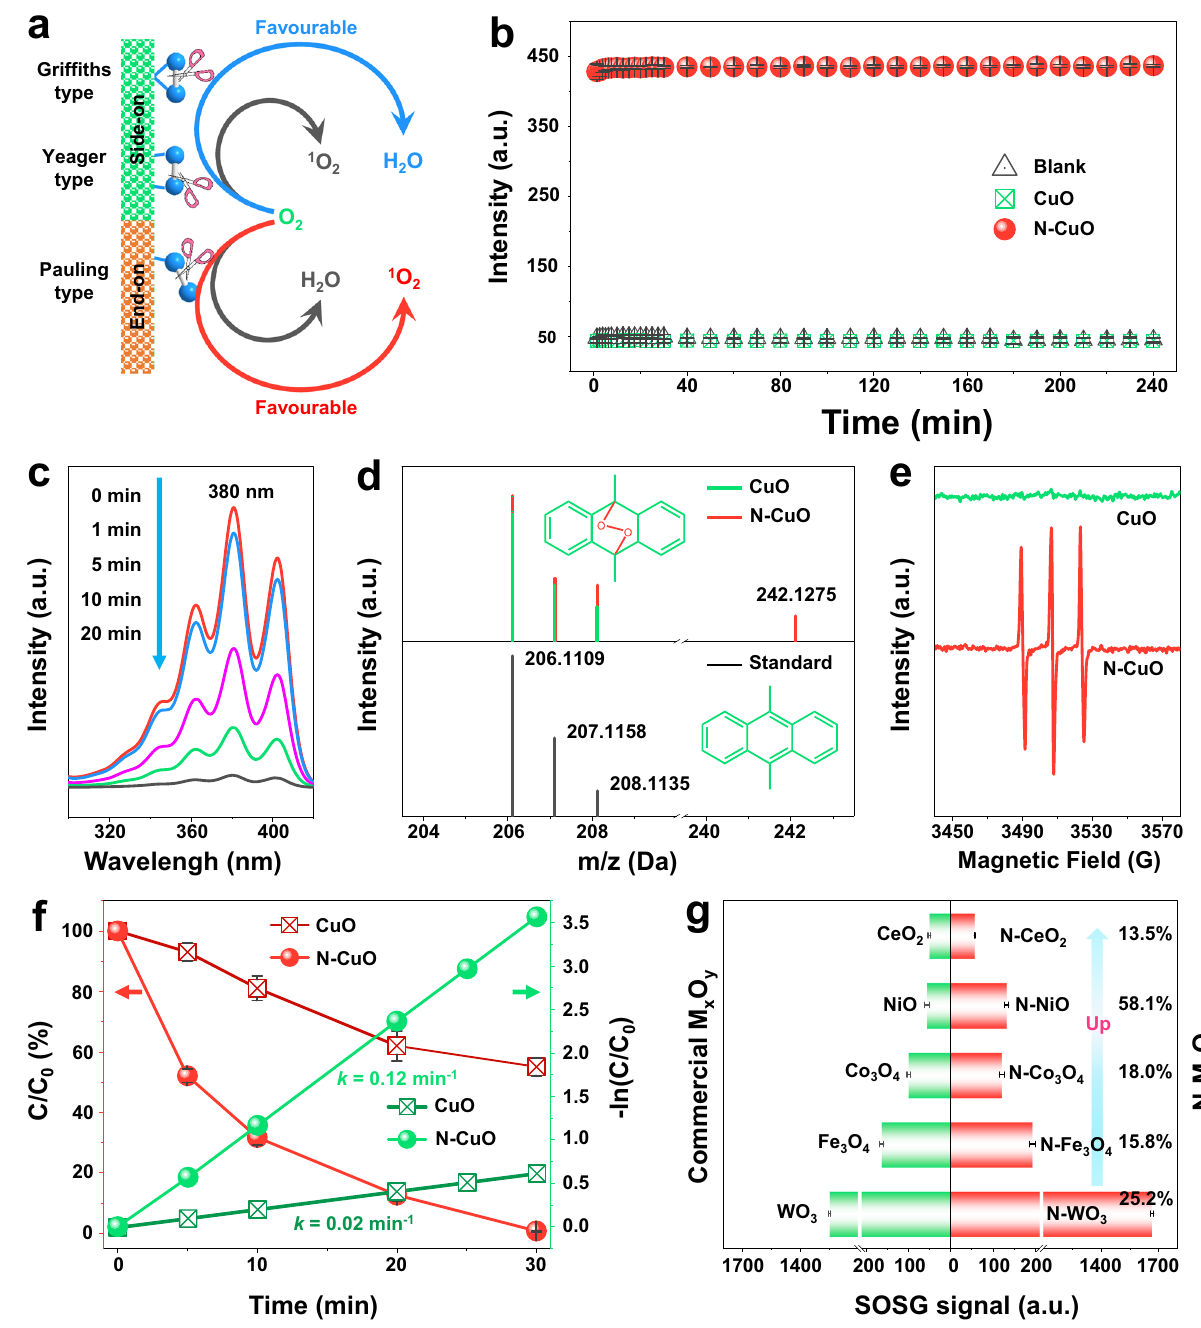
Fig. 1 | Electrocatalytic performance of N – CuO towards 1 O 2 production. a Schematicof the molecularoxygen activation pathwayof “ side-on ” and “ end-on ” adsorption con fi guration on catalyst surface. b Fluorescence response of SOSG upon treatment with CuO and N – CuO within 240min ( λ ex =504nm and λ em =525 nm). c Excitation and emission spectra of DMA in 10wt% acetonitrile in H 2 O upon treatment with N – CuO system. The excitation was recorded from 280 to 420nm with λ em =425nm. d HR-MS chromatogram of the typical DMA-O 2 from the N – CuO system. The degradation kinetic model ( k value) of the N – CuO